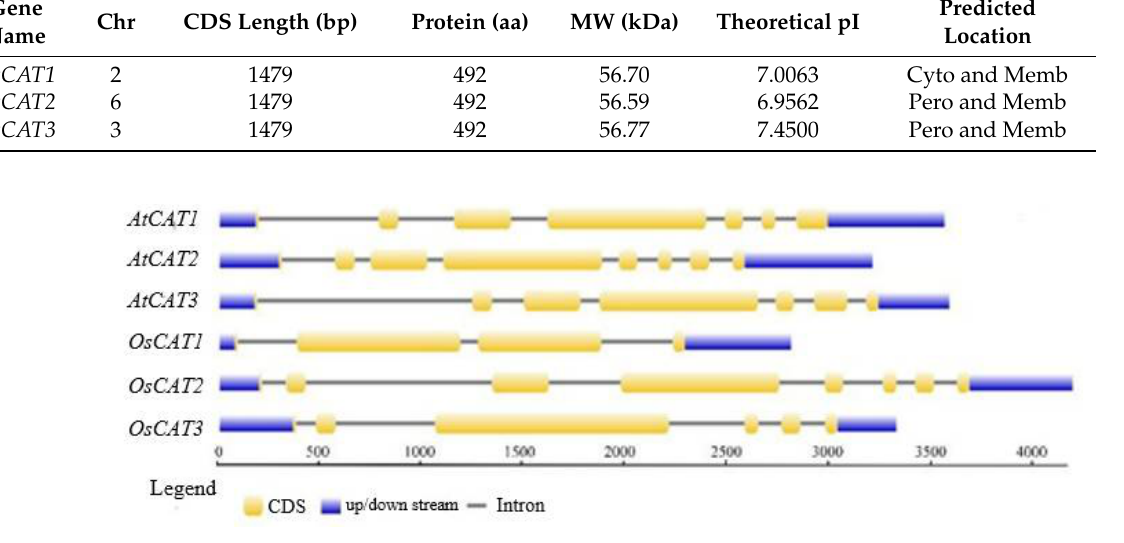
Figure 1. The gene structure of the CAT family genes from Arabidopsis thaliana and Oryza sativa . Blue color shows the UTR regions, yellow color shows the CDS or exons, black horizontal line shows the introns.